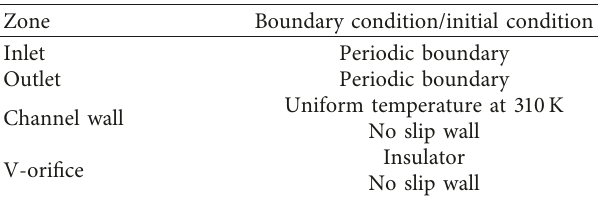
Table 2: Boundary condition and initial condition.